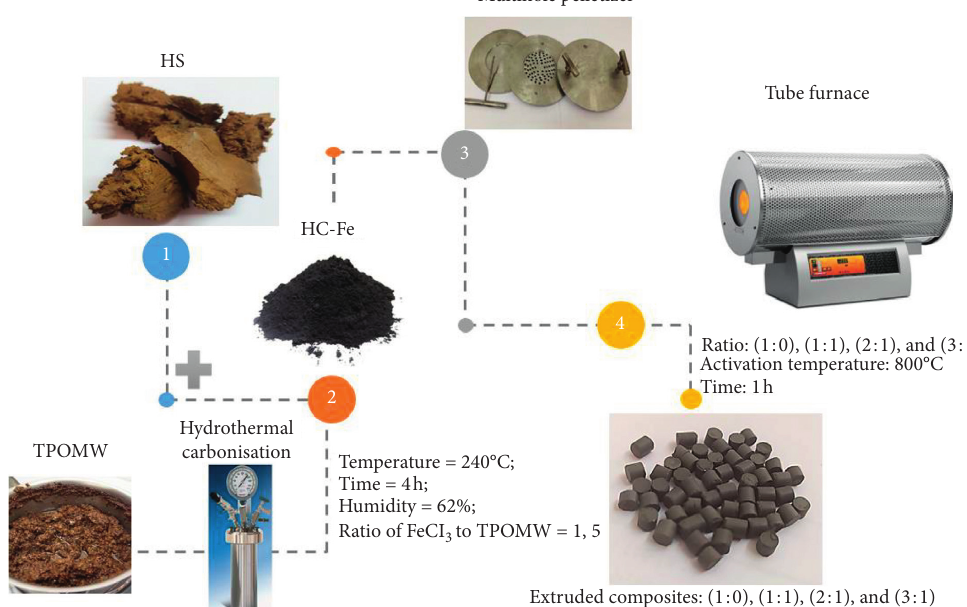
Figure 1: Protocol used for the preparation of extruded composites.